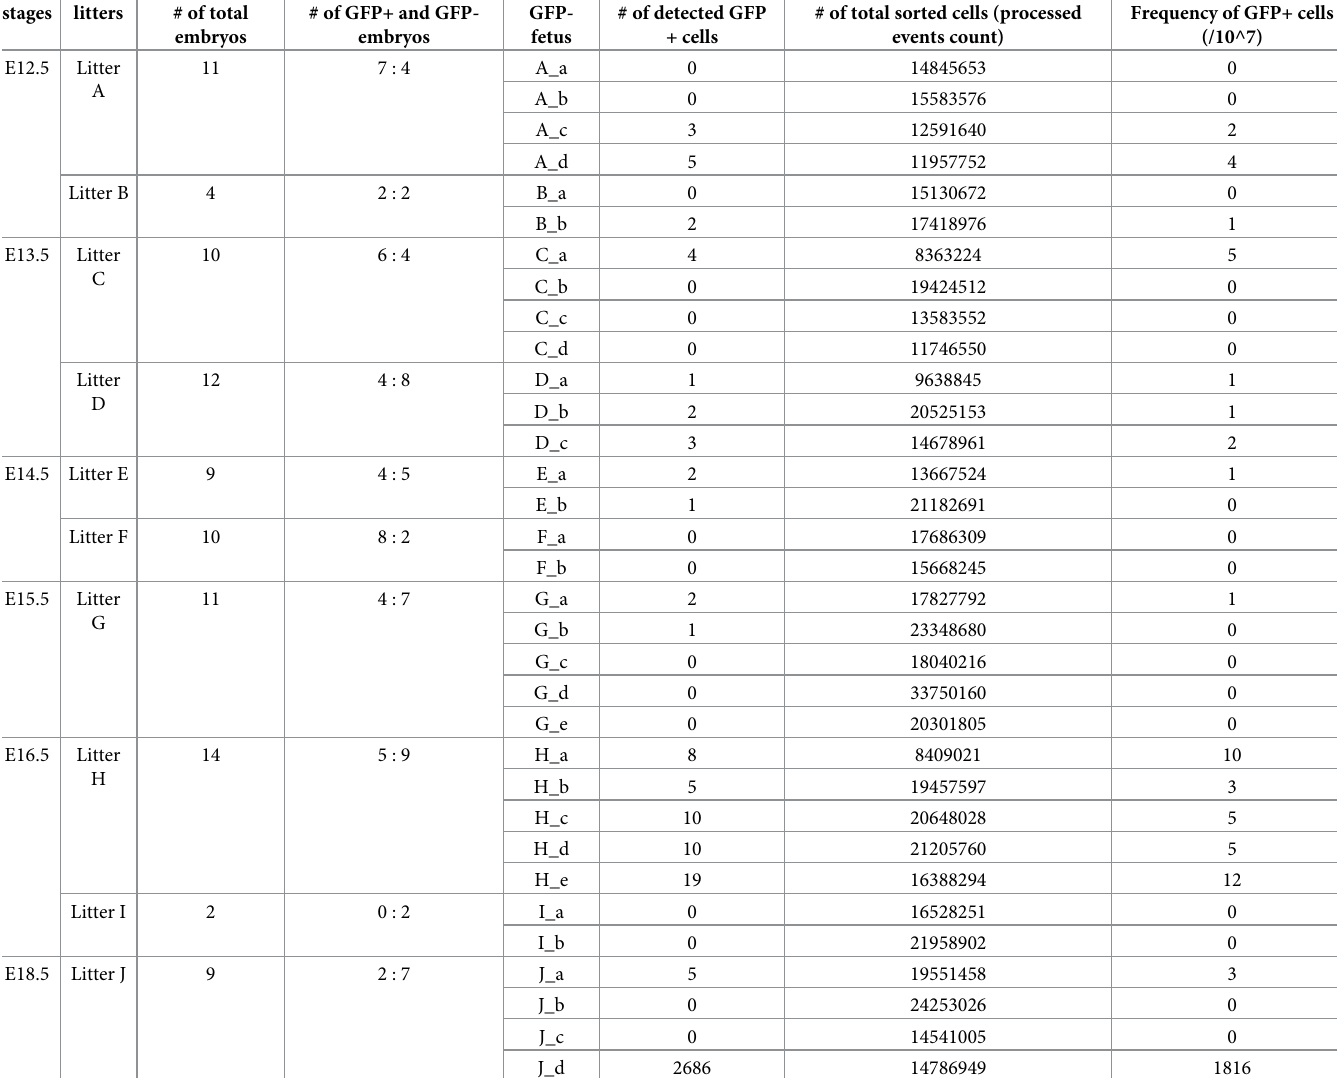
Table 1. Detailed information of GFP+ and GFP- fetal samples in Fig